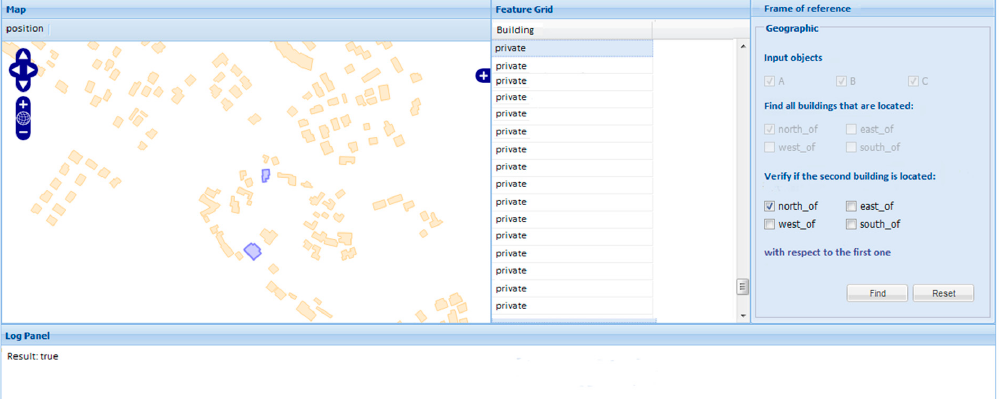
Figure 14. Boolean directional relation north_of .